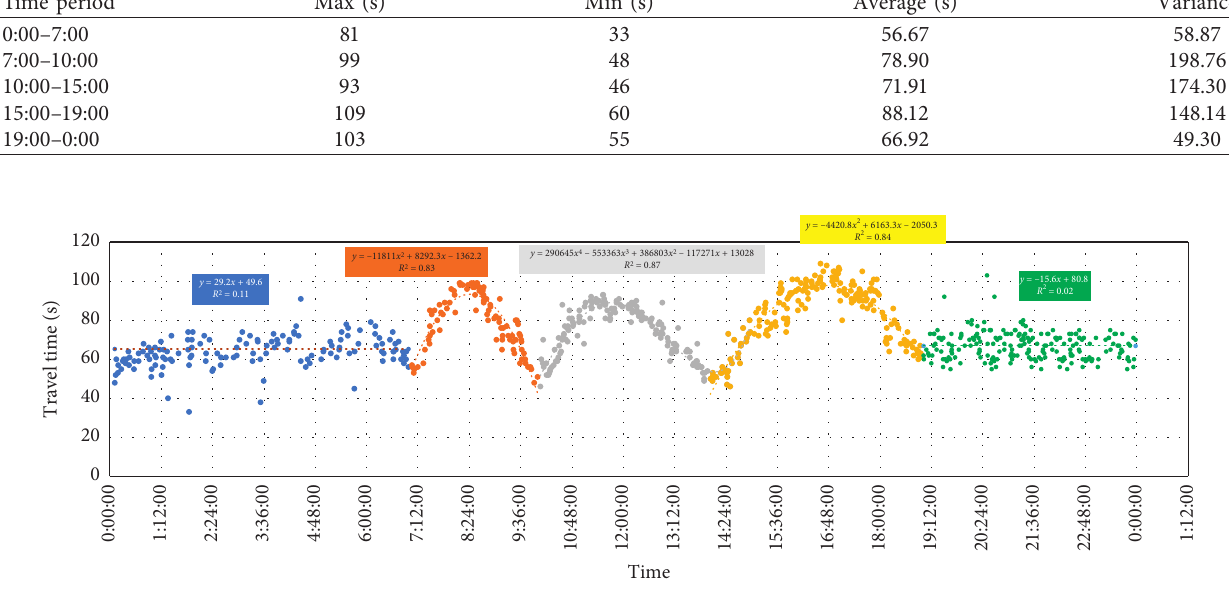
Figure 3: Scatter plot and regression results of travel time for different periods of the day. Table 4: Details of the regression functions for travel time of different periods of the